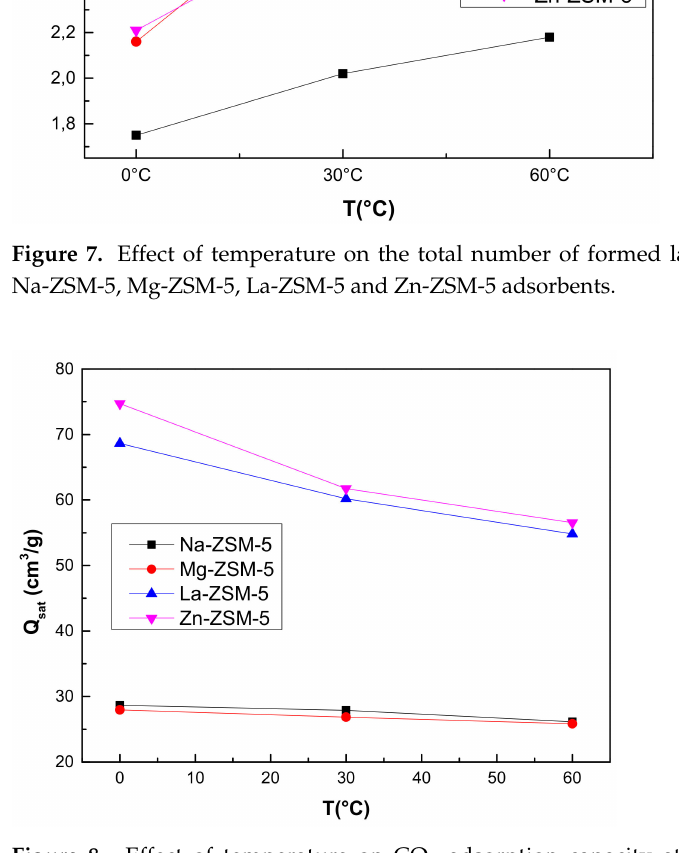
Figure 8. Effect of temperature on CO 2 adsorption capacity at saturation for the Na-ZSM-5, Mg-ZSM-5, La-ZSM-5 and